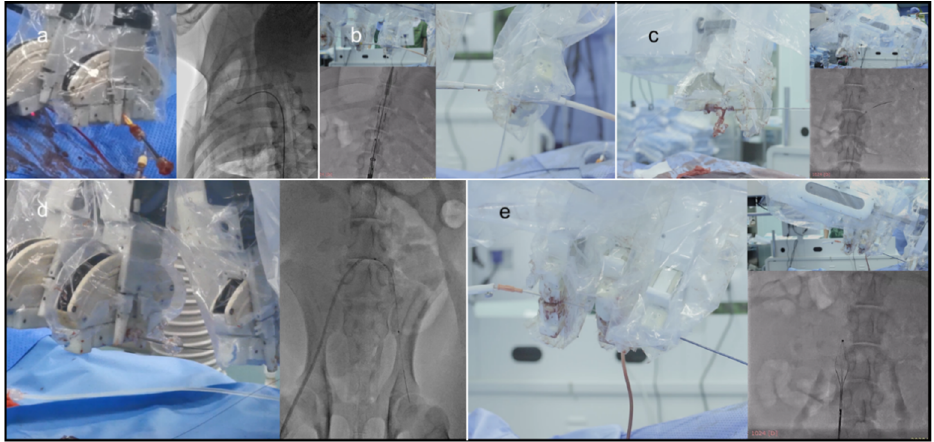
Figure 8. The angiograph results of five types of operations. ( a ): Percutaneous coronary intervention; ( b ): thoracic endovascular aortic repair; ( c ): stent implantation of renal artery; ( d ): iliac artery stent implantation; ( e ): implantation of inferior vena cava filter.